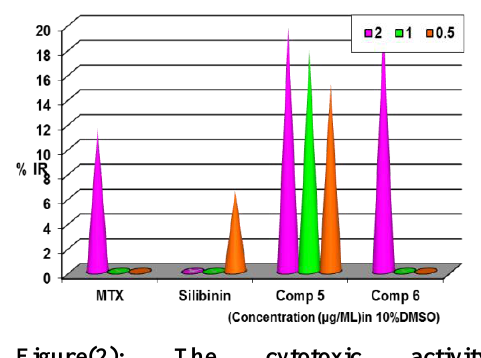
Figure(2): The cytotoxic activity represented by inhibition rate percent of compounds MTX,silibinin,compound 5,6 at different concentrations(2,1,0.5) μg/ml in 48 hrs time of